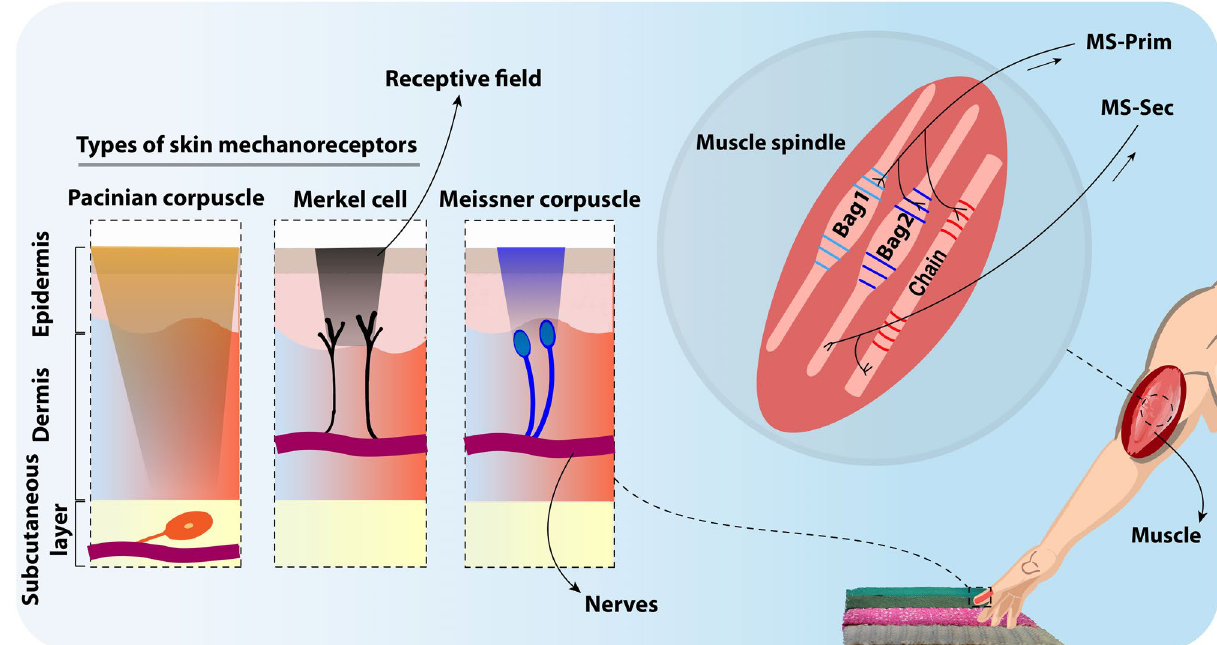
Figure 1. The schematic of the biological sensory system. Left, illustration of tactile mechanoreceptors with their receptive fields within human skin to sense surface details. Right, the muscle spindle organ with three types of intrafusal fibers that respond through primary (MS-Prim) and secondary (MS-Sec) afferents for encoding the position and velocity of the